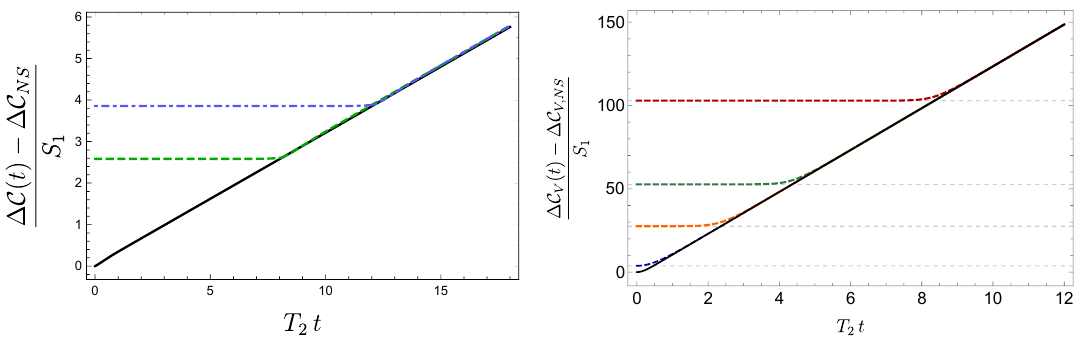
Figure 22. Complexity evolution in d = 2 for light shock waves. Left: using the CA proposal for w = 1+10 (cid:0) 5 and ~ ‘ ct = 1. The unperturbed evolution is indicated by a solid blue line. We also plot the complexity evolution in the presence of shock waves | with T 2 t w = 6 (dashed green) and 8 (dot-dashed light-blue). The initial values for those curves was (cid:12)xed according to the complexity of formation. We see that the complexity does not change for a long period of time, and at late times, the complexity follows that of the unperturbed evolution. Right: time evolution of complexity using the volume conjecture for w = 1 + 10 (cid:0) 5 . The unperturbed evolution is plotted in black and the evolution in the presence of the shock is in dashed colored lines | T 2 t w = 6 (red), 4 (green), 3 (orange) and 2 (blue). The evolution again begins with a plateau at early times and then joins the unperturbed evolution.